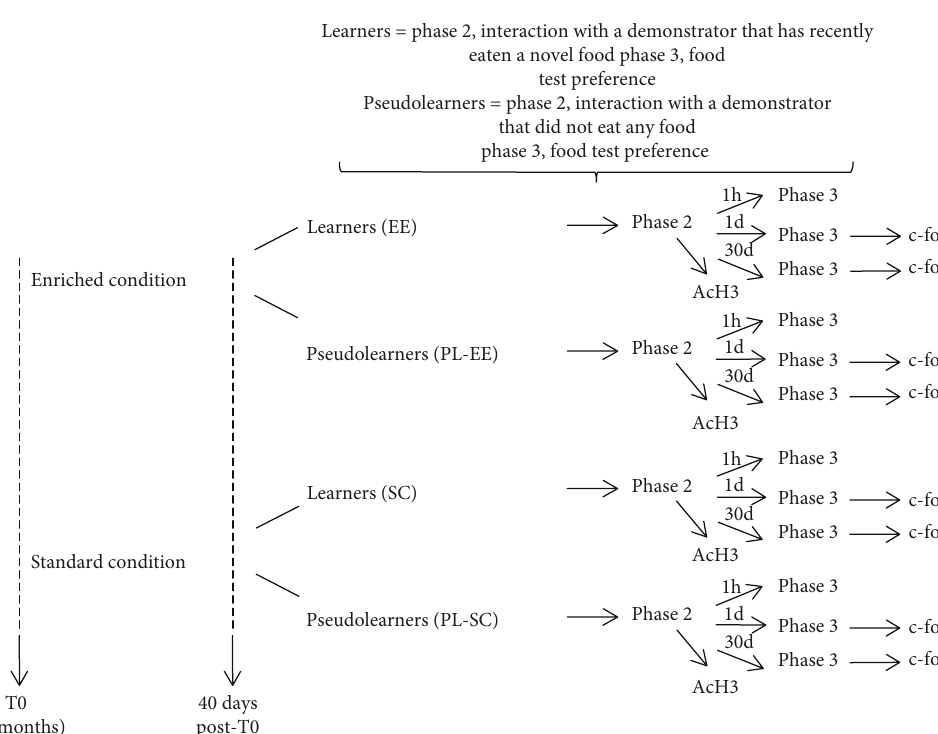
Figure 1: Schematic diagram of the experimental